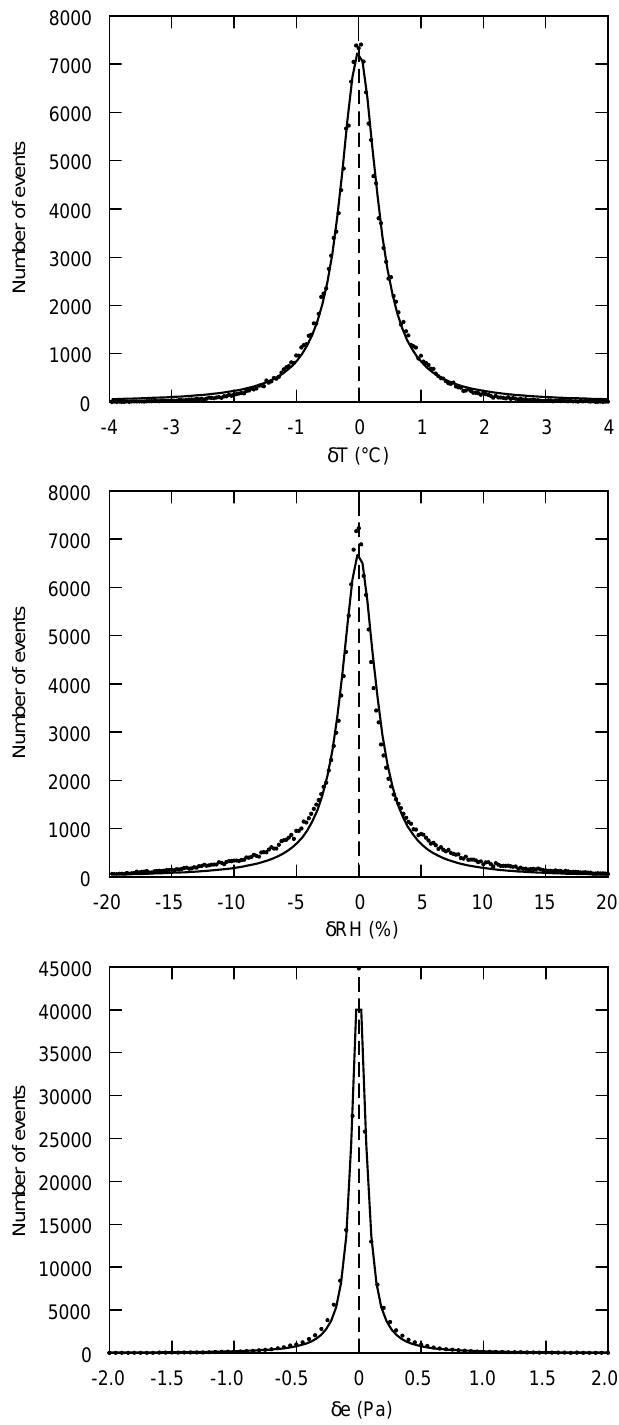
Fig. 4. Distributions ( dotted ) of the temperature ( upper ), relative humidity ( middle ), and water vapour partial pressure fluctuations ( lower panel ) for ECHAM level 7 (166–222 hPa) over areas that correspond to the size of an ECHAM-T42 grid cell (i.e. about 300 (cid:2) 300 km 2 ). The solid lines are Lorentz curves fitted to the distributions. The corresponding distributions for ECHAM level